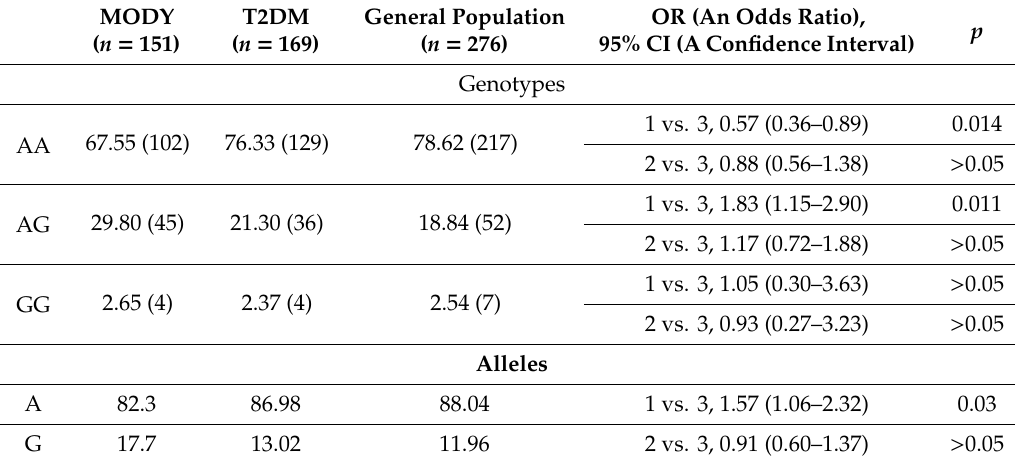
Table 2. Frequencies of alleles and genotypes of rs11544593 in the general-population group (Western Siberia; control), in the type 2 diabetes mellitus group, and among patients with a maturity-onset diabetes of the young phenotype in Russia.